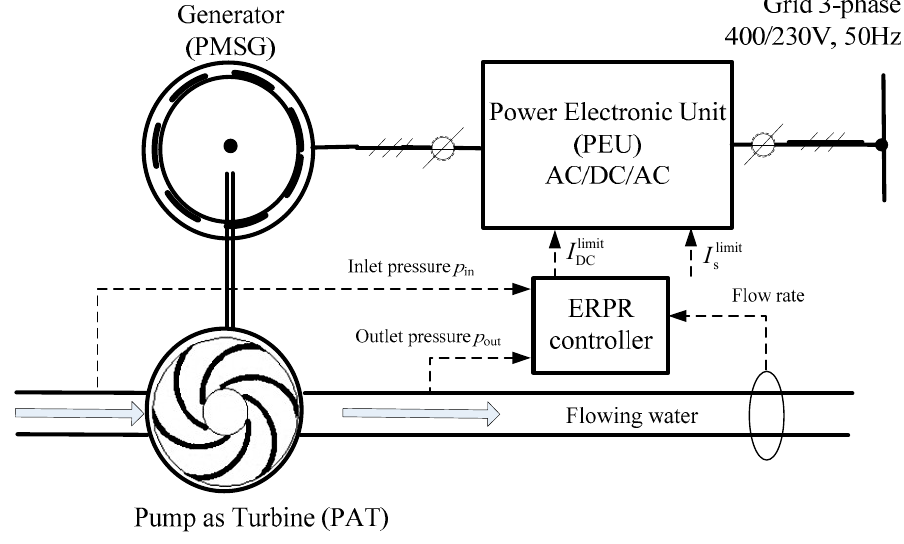
Figure 3. Main elements of an ERPR.